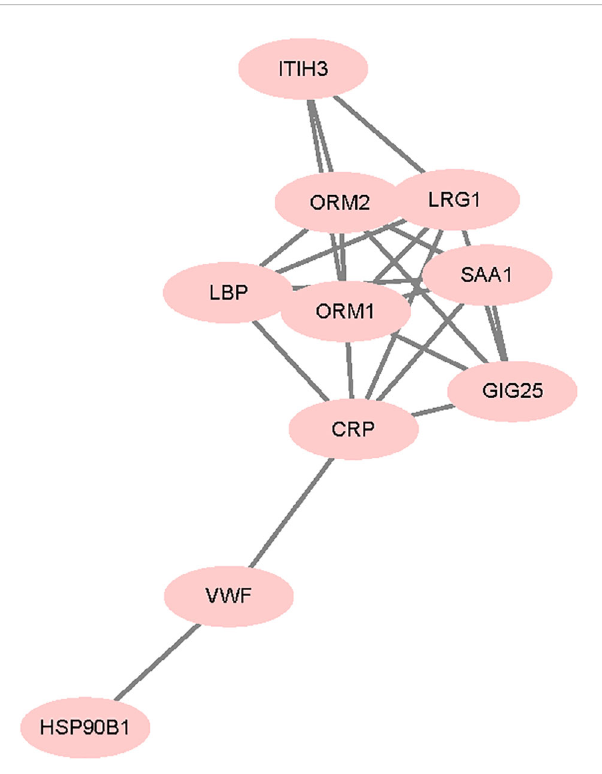
FIGURE 7 Differentially expressed protein interaction networks. Nodes represent proteins and lines represent protein-protein